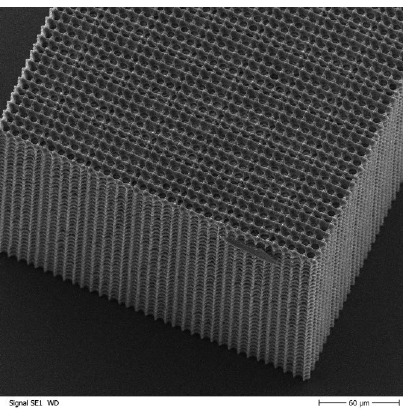
Figure 12. Structure with 35x35x35 micro cells, Detail 1